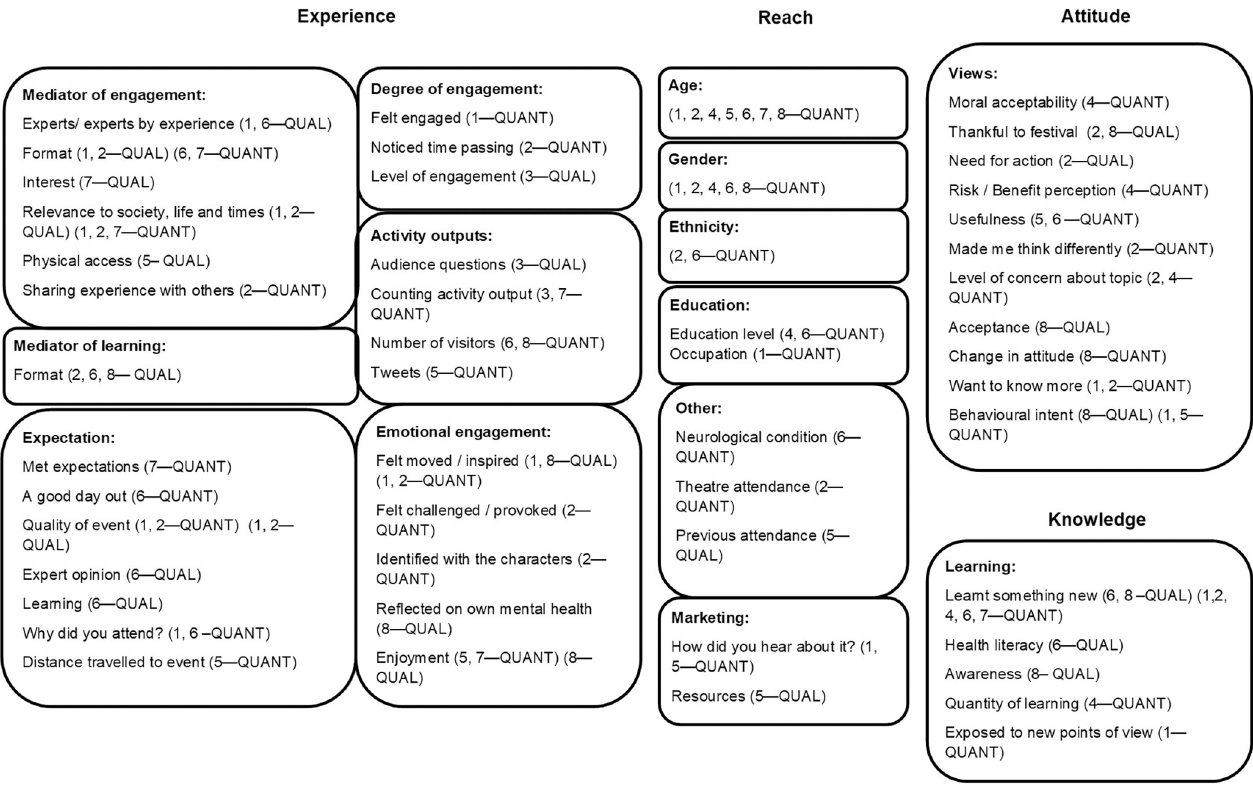
Fig 2. Conceptual map of evaluated outcomes and